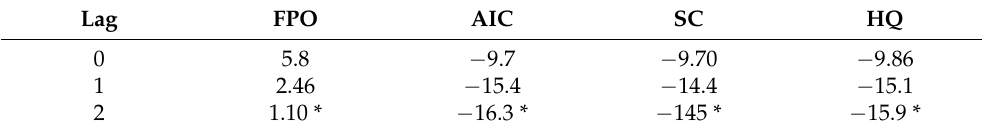
Table 2. Optimal lag selection criteria. Lag